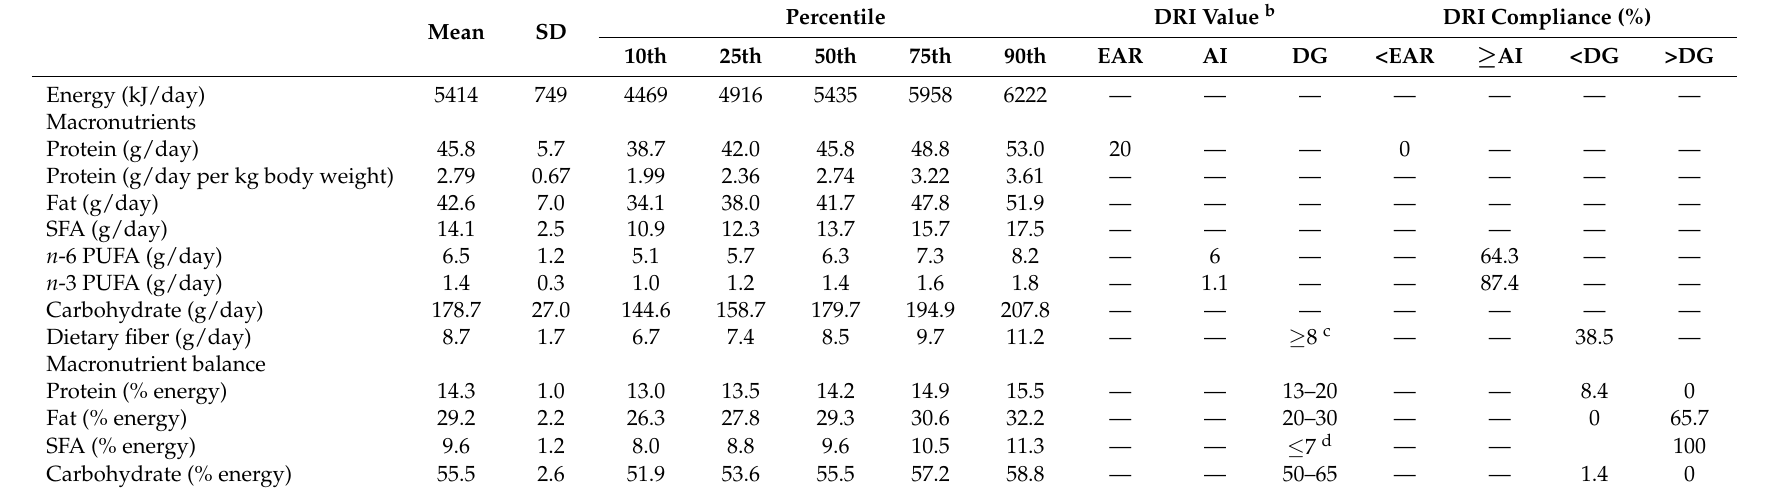
Table 3. Usual intakes of energy and macronutrients from foods and beverages for Japanese girls aged 3–5 years ( n = 143) a